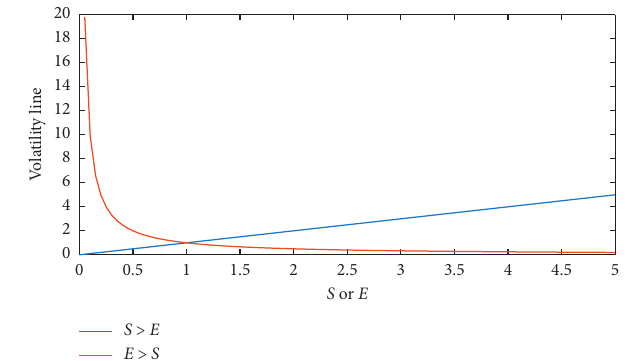
Figure 2: Volatility when S < E and E < S .